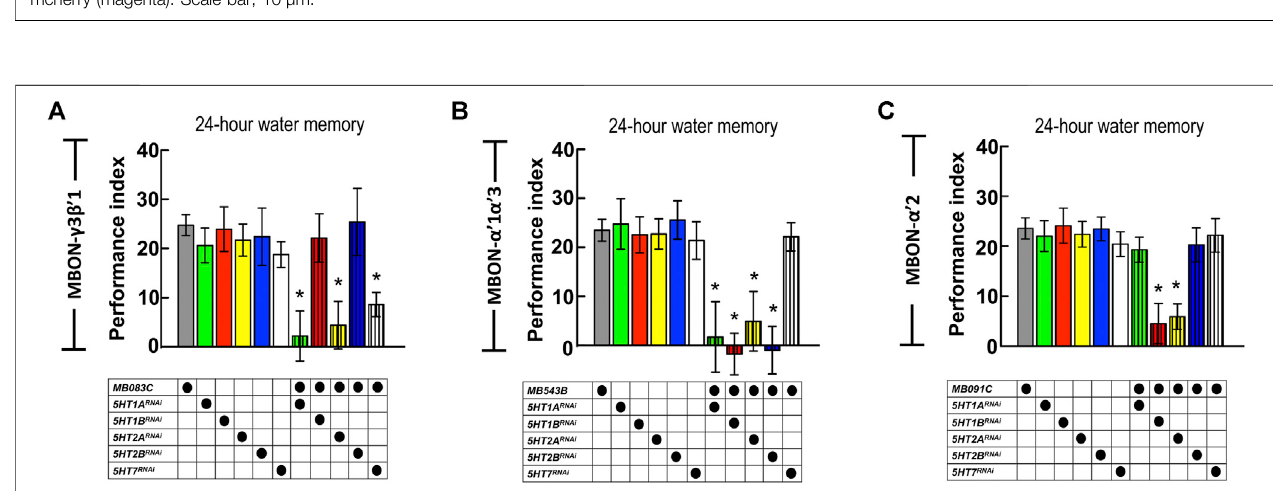
FIGURE 7 | Suppressing 5HT receptor expression in MBON- γ 3 β ′ 1, MBON- α ′ 1 α ′ 3, and MBON- α ′ 2 disrupted wLTM. (A) RNAi-mediated silencing of 5HT1A , 5HT2A , and 5HT7 inMBON- γ 3 β ′ 1disrupted wLTM formation. Each valuerepresentsmean ± SEM(N (cid:1) 26,10,10,10, 8,12,10,9,10, 8,and10from lefttorightbars). * p < 0.05;one-wayANOVAfollowedbyTukey ’ stest. (B) RNAi-mediatedsilencingthe 5HT1A , 5HT1B , 5HT2A ,and 5HT2B inMBON- α ′ 1 α ′ 3disruptedwLTMformation. Each value represents mean ± SEM (N (cid:1) 30, 13, 11, 10, 9, 8, 10, 9, 10, 9, and 8 from left to right bars). * p < 0.05; one-way ANOVA followed by Tukey ’ s test. (C) RNAi-mediated silencing the 5HT1B and 5HT2A in MBON- α ′ 2 disrupted wLTM formation. Each value represents mean ± SEM (N (cid:1) 33, 11, 10, 19, 9, 10, 11, 10, 19, 8, and 12 from left to right bars). * p < 0.05; one-way ANOVA followed by Tukey ’ s test.